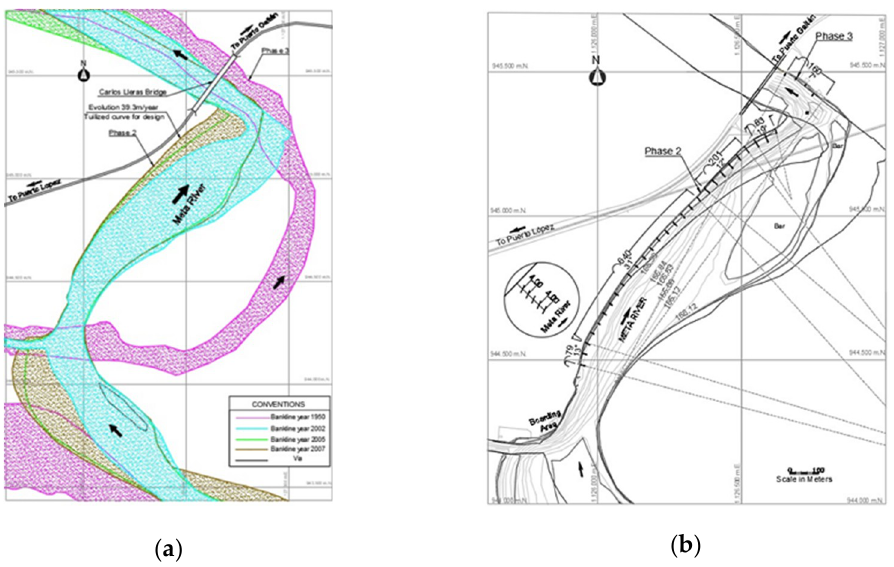
Figure 12. Rio Metica, Puerto López: ( a ) summary of the analysis of the evolution of the river among 1950, 2002, 2005, and 2007; ( b ) sector geometry and panel field design. Note the proximity of the river to the road in 2005 (Hidroconsulta, 2005 [13]; 2007 [12]).